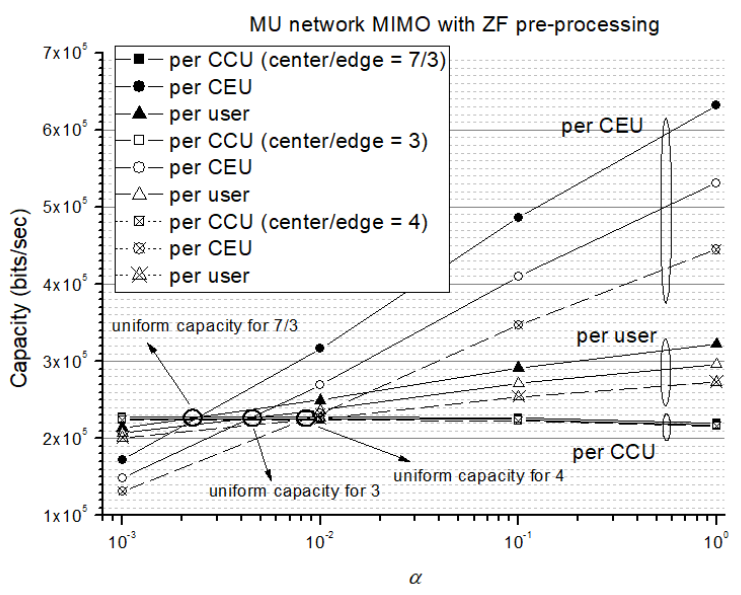
Figure 13. Capacity comparison between different values of center-edge area ratio for MU-network MIMO with ZF joint preprocessing.